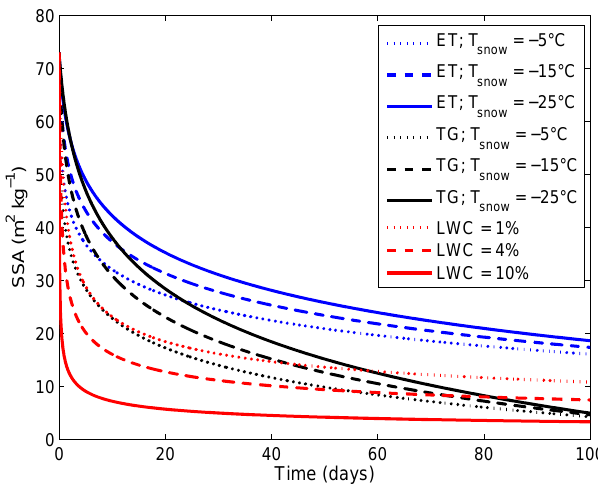
Fig. 2. SSA evolution as a function of the temperature gradient regime (ET or TG with LWC = 0) and snow temperature ( T snow ) from Eqs. (2) and (3), as well as a function of liquid water content (LWC) from Eq.